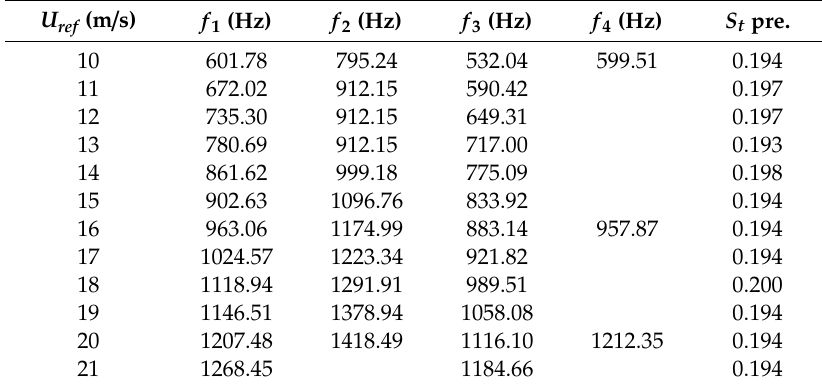
Table 4. Vortex-shedding frequency at di ff erent inflow velocities; f 1 : frequency obtained in this study; f 2 and f 3 : frequencies obtained from smooth and rough leading edge experiments, respectively [8]; f 4 : frequency obtained through a CFD simulation in this study.